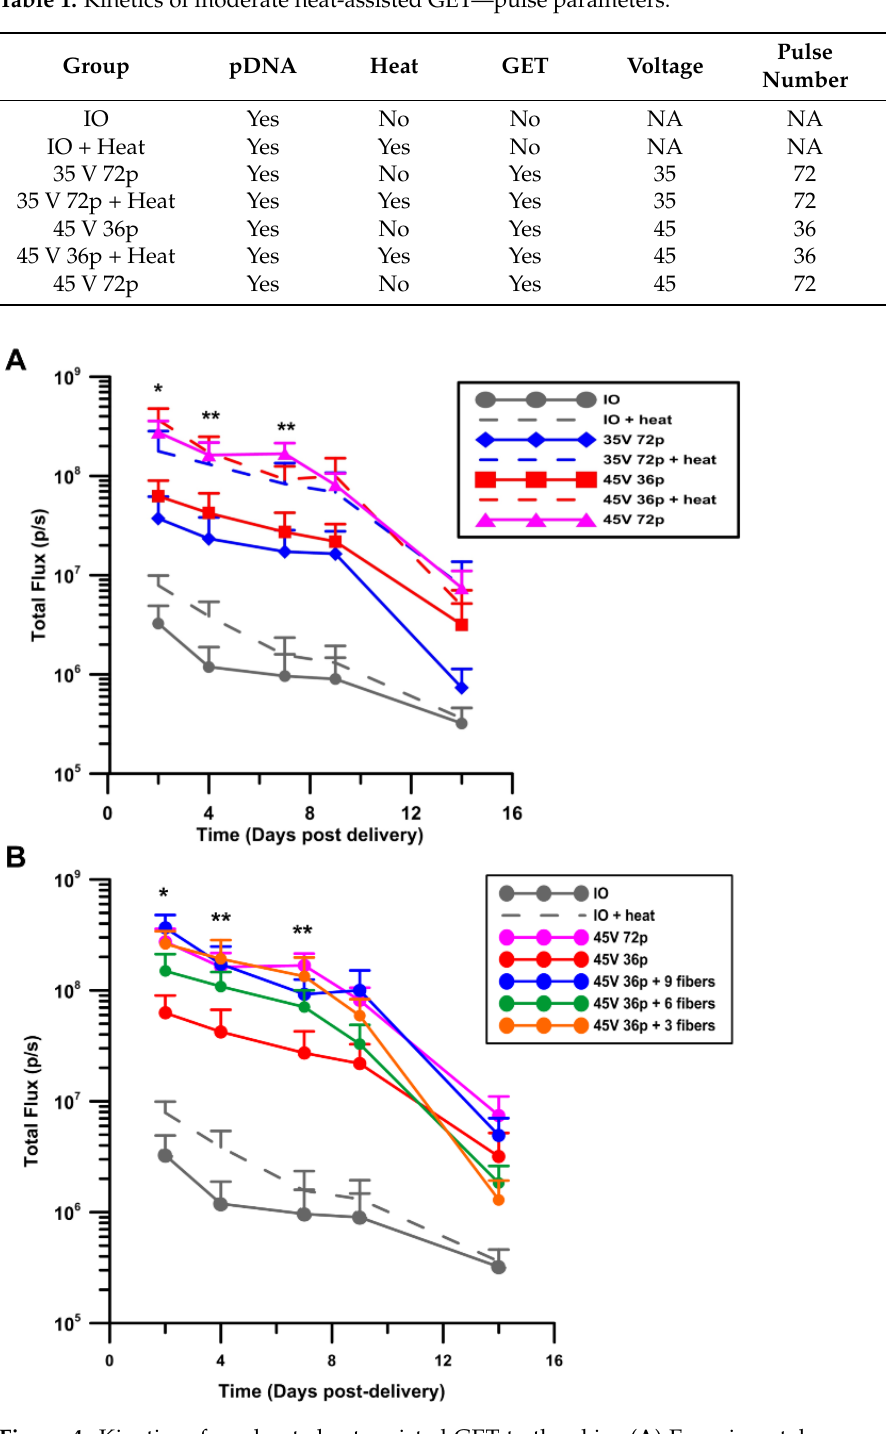
Figure 4. Kinetics of moderate heat-assisted GET to the skin. ( A ) Experimental groups included injection only (IO) plus heat (IO + heat), injection of pDNA followed by 72 pulses at 45 V (45 V 72p) or 35 V (35 V 72p), 72 pulses at 35 V with moderate heat (35 V 72p + heat), and 36 pulses at 45 V with (45 V 36p + heat) or without heating (45 V 36p). ( B ) Flexibility and distribution of heating was assessed for 3, 6, and 9 active optical fibers followed by GET at 45 V 36p. Luciferase expression levels reported as average total flux (photons/second) ± SEM, n = 6–8 individual sites per group. * p < 0.05, ** p < 0.01.